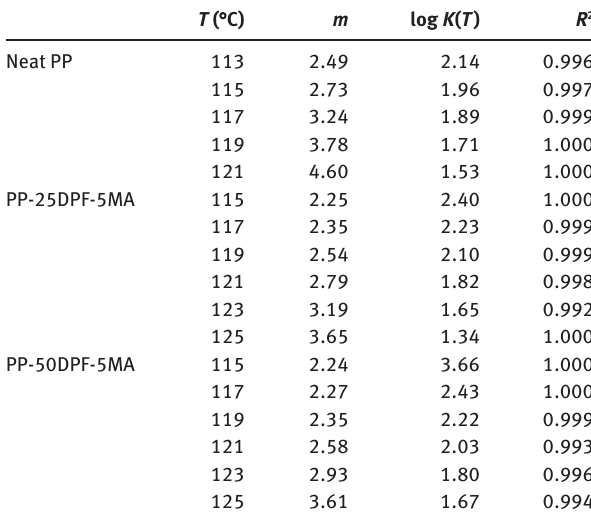
Table 3: Ozawa’s parameters for neat polypropylene (PP) and PP-DPF composites.